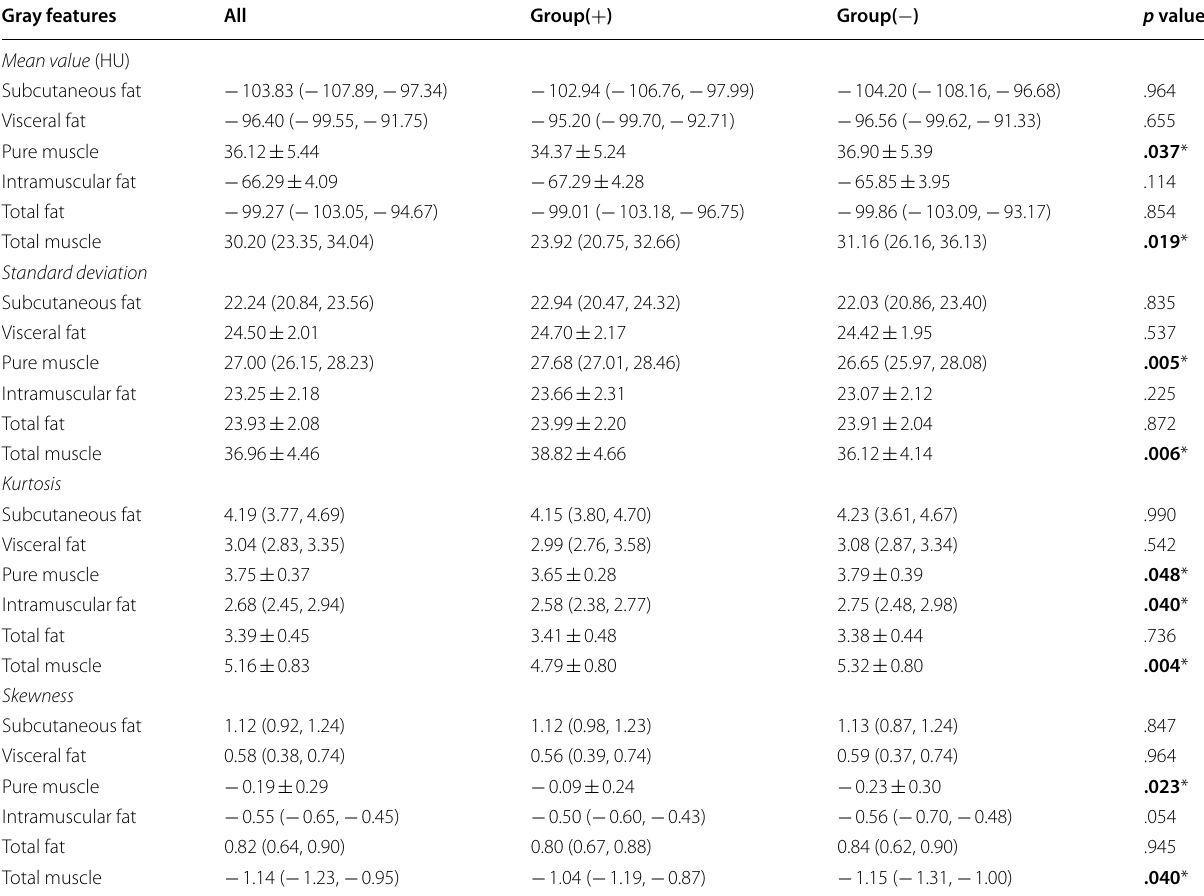
Table 3 Gray feature analysis of abdominal body